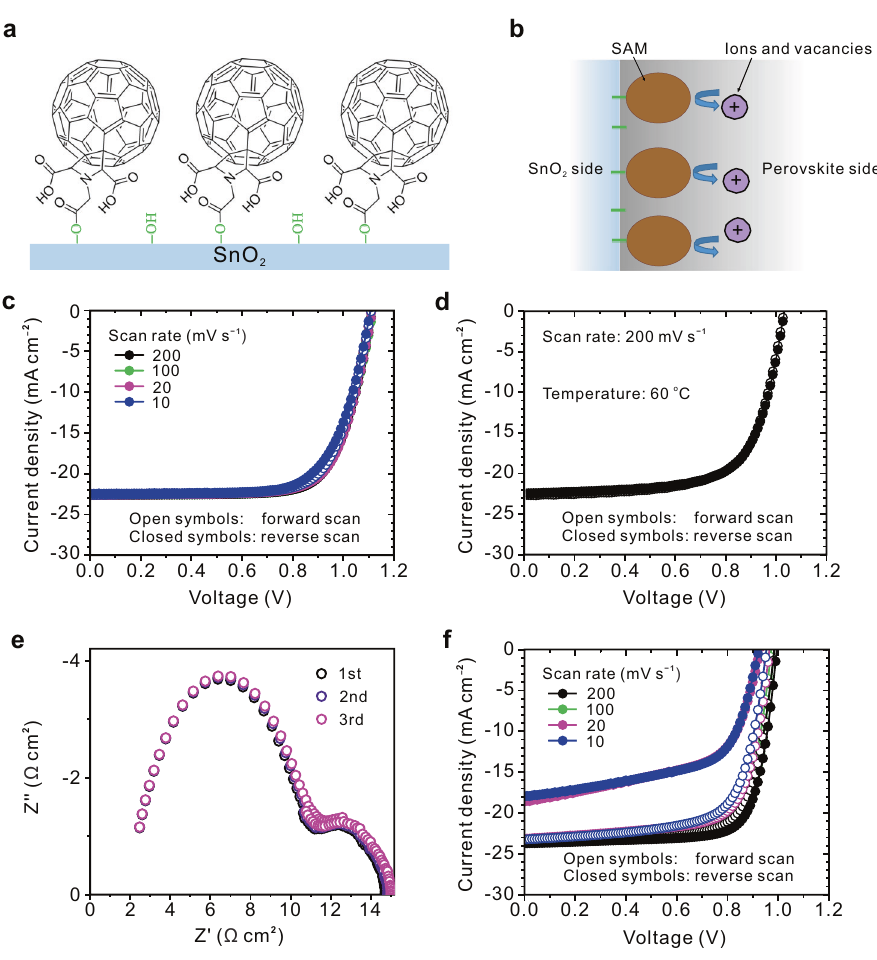
Fig. 3 Positive effect of using a self-assembled monolayer (SAM) on the hysteresis and carrier recombination characteristics in perovskite solar cells. Illustration showing a a self-assembled monolayer formed on the SnO 2 surface and b reduced localized ionic charges at the surface of SnO 2 because of the deactivation of surface – OH groups. c Scan-rate-dependent current density – voltage curves of perovskite solar cells with a self-assembled monolayer at room temperature. d Current density – voltage curves measured at a fast scan rate of 200 mV s − 1 at 60 °C. e Electrochemical impedance spectroscopy results of perovskite solar cells with a self-assembled monolayer. f Scan-rate-dependent current density – voltage curves of perovskite solar cells with a C 60 layer at room